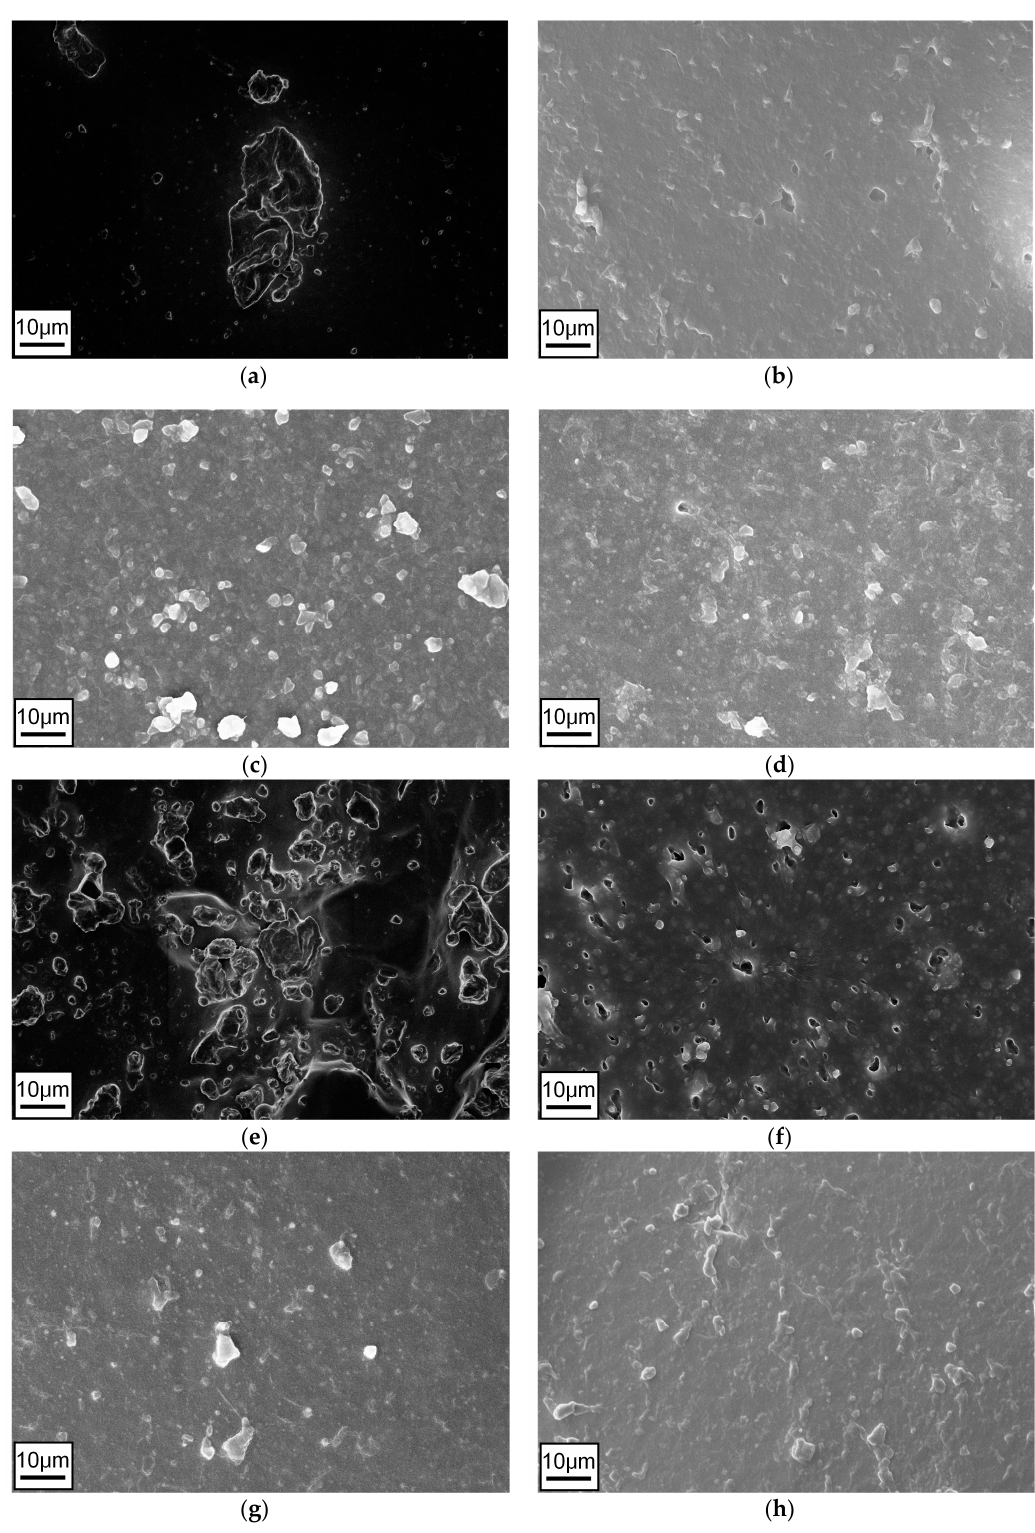
Figure 9. SEM images of RTV silicone rubber—1000× magnification. ( a ) Sample 1, virgin; ( b ) Sample 1, aged for 20 days; ( c ) Sample 1, aged for 40 days; ( d ) Sample 1, aged for 60 days; ( e ) Sample 2, virgin; ( f ) Sample 2, aged for 20 days; ( g ) Sample 2, aged for 40 days; and ( h ) Sample 2, aged for 60 days.